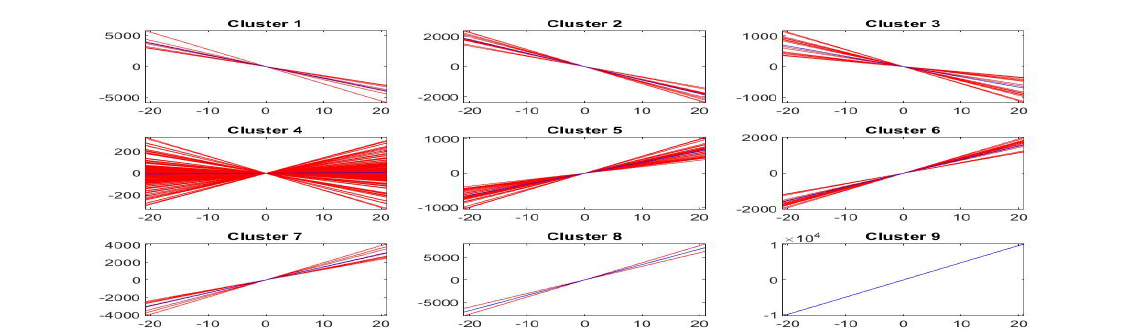
Figure 24. Clustering of L 2 -norm F-transform components (polynomials) of order 1 for Bitcoin series. The fuzzy r -partition is P b with r = 3.